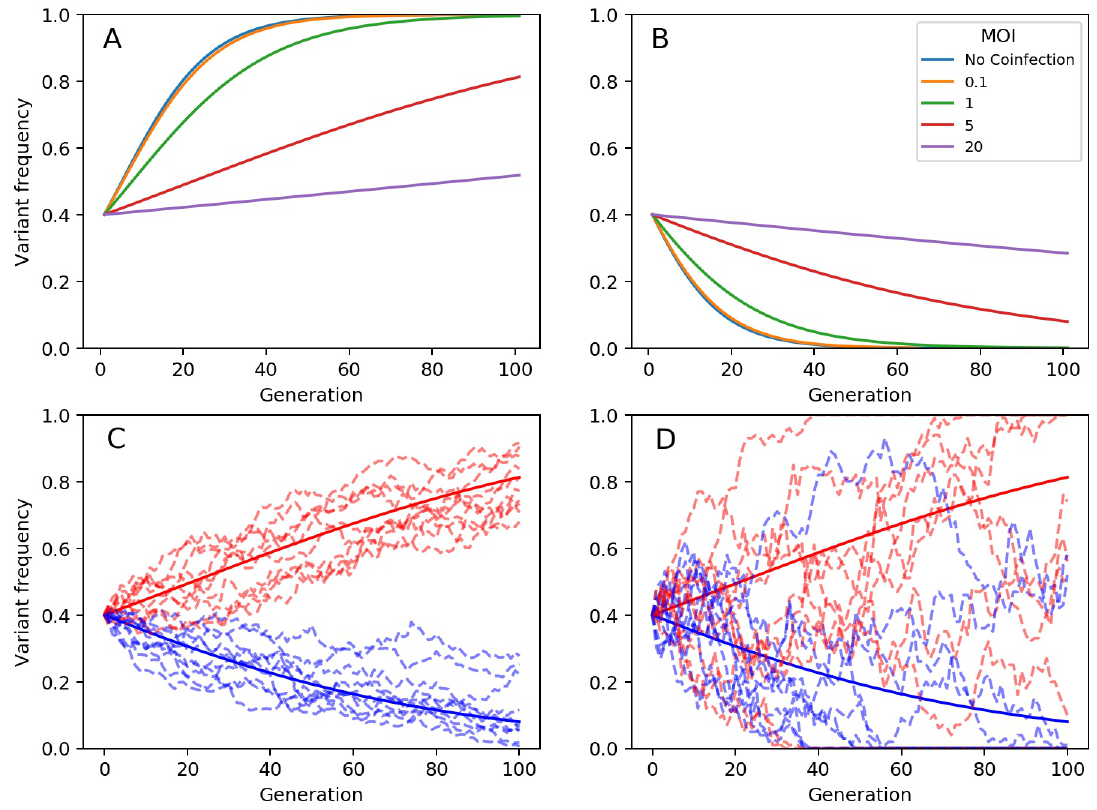
Figure 1. Model simulations showing changes in variant frequencies over viral generations. ( A ) Frequency changes of a beneficial mutation under the deterministic within-host model, parameterized at different mean cellular multiplici- ties of infection M . For all simulations shown, the variant’s fitness is e σ m = 1.1 and its initial frequency is q m ( t 0 ) = 0.4. ( B ) Frequency changes of a deleterious mutation under the deterministic within-host model, parameterized at different mean cellular multiplicities of infection M . For all simulations shown, the variant’s fitness is e σ m = 0.9 and its initial frequency is q m ( t 0 ) = 0.4. In ( A , B ), we consider MOI values of 0.1, 1, 5, and 20. Labeled as ‘No coinfection’, we also plot simulations of the model presented in Equation (1), which assumes that fitness is an individual-level property of a viral genome. ( C ) Frequency changes of a beneficial mutation (red; e σ m = 1.1) and of a deleterious mutation (blue; e σ m = 0.9) under the stochastic within-host model, parameterized with a mean cellular MOI of 5. Dashed lines show 10 stochastic realizations under each parameterization. Solid lines show simulations of the deterministic model under the same parameterization. Stochastic simulations used an effective viral population size of N = 1000. ( D ) Frequency changes of mutations, as in ( C ), only using an effective viral population size of N =